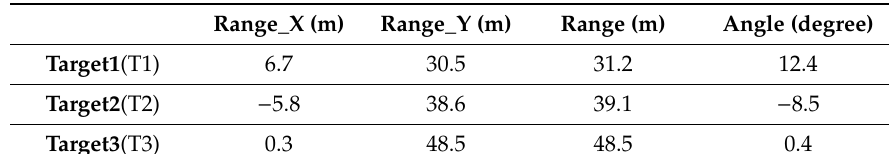
Figure 10. Scenario for the measured data set collection with 3 highlighted targets. Table 3. Actual target parameters of 3 targets.